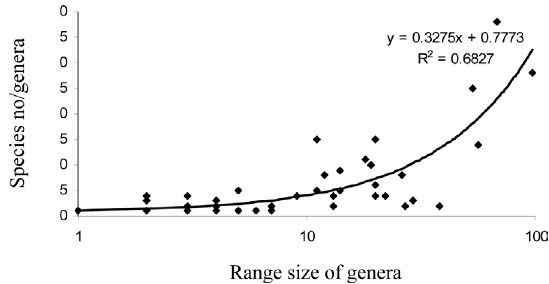
Figure 4. Relationships between (log) range size of genera and species number/genera ratio for Scuridae worldwide.